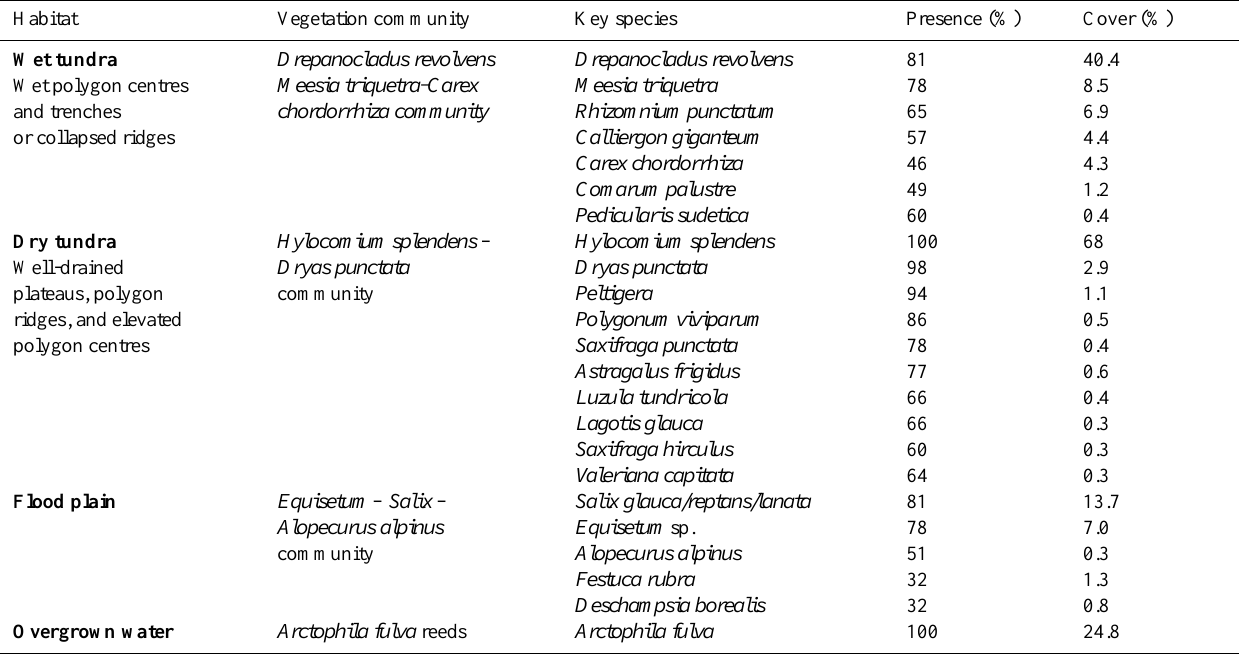
Table 2. Dominant vegetation communities and key species on Samoylov Island by presence of key species in corresponding vegetation community (%) and proportion of corresponding vegetation community covered by key species